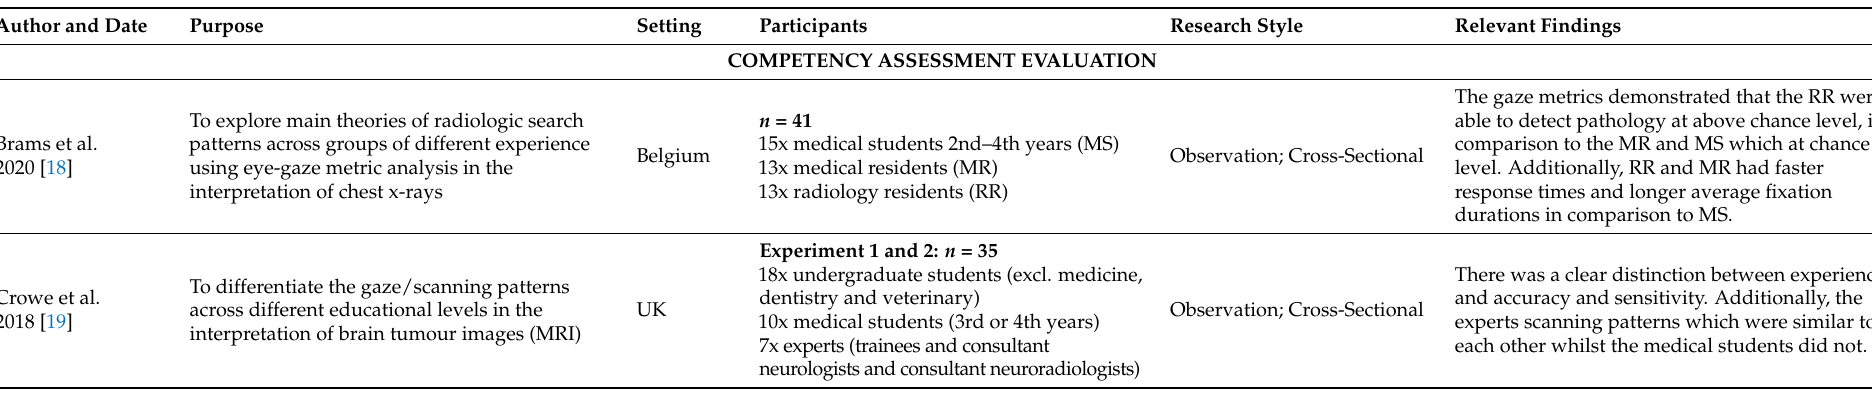
Table 3. Study characteristics of eligible studies that were